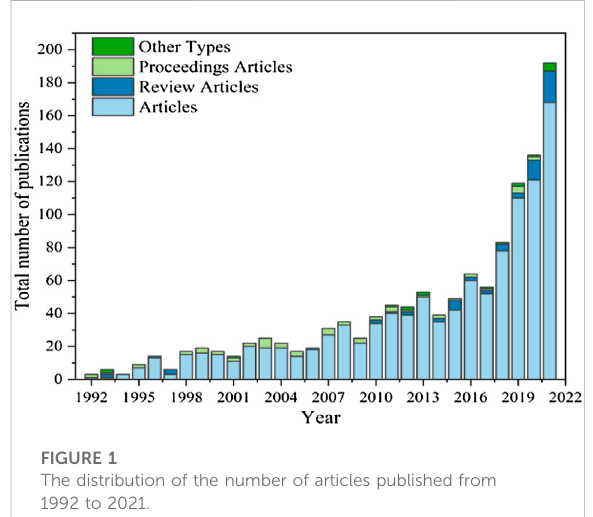
FIGURE 1 The distribution of the number of articles published from 1992 to 2021.